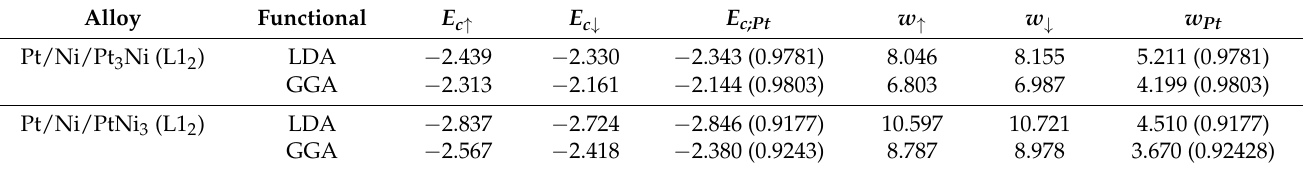
Table 7. The spin-resolved first and second moments of the d-band of the surface Pt atoms in the Pt 3 Ni and PtNi 3 alloy- bearing systems and in the surface Pt atoms in strained Pt(111). The up and down arrows denote the spin up and down components of the surface Pt atoms in the alloy systems, and ‘Pt’ denotes the surface Pt atoms in strained Pt(111). The number in brackets after the E c;Pt and w Pt is the strain σ at which the quantity was determined. The ‘Functional’ column shows the exchange-correlation functional used (LDA/GGA). All the band centers are relative to the Fermi energy; all the energies and widths are in eV.